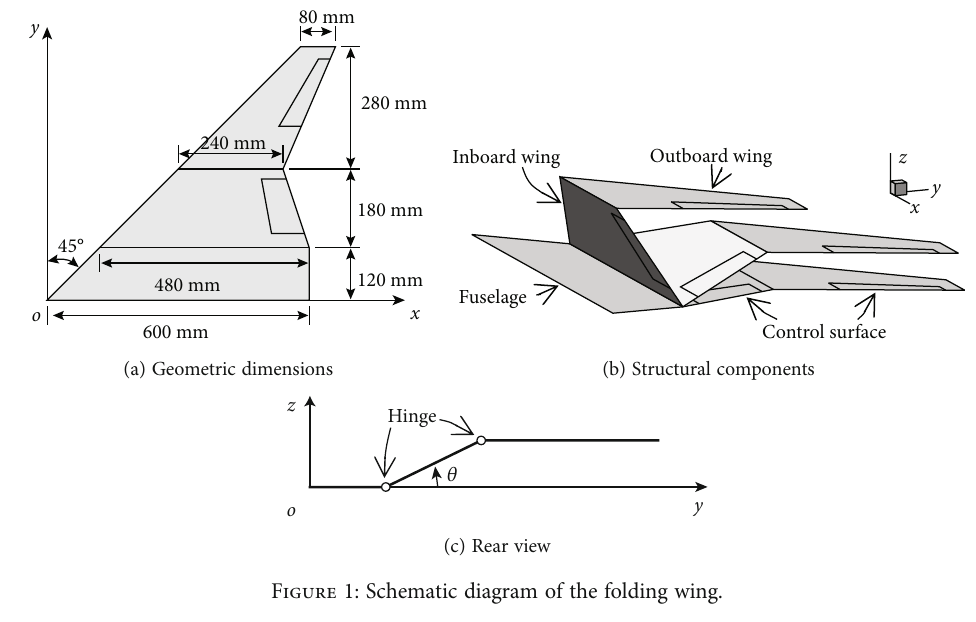
Figure 1: Schematic diagram of the folding wing.